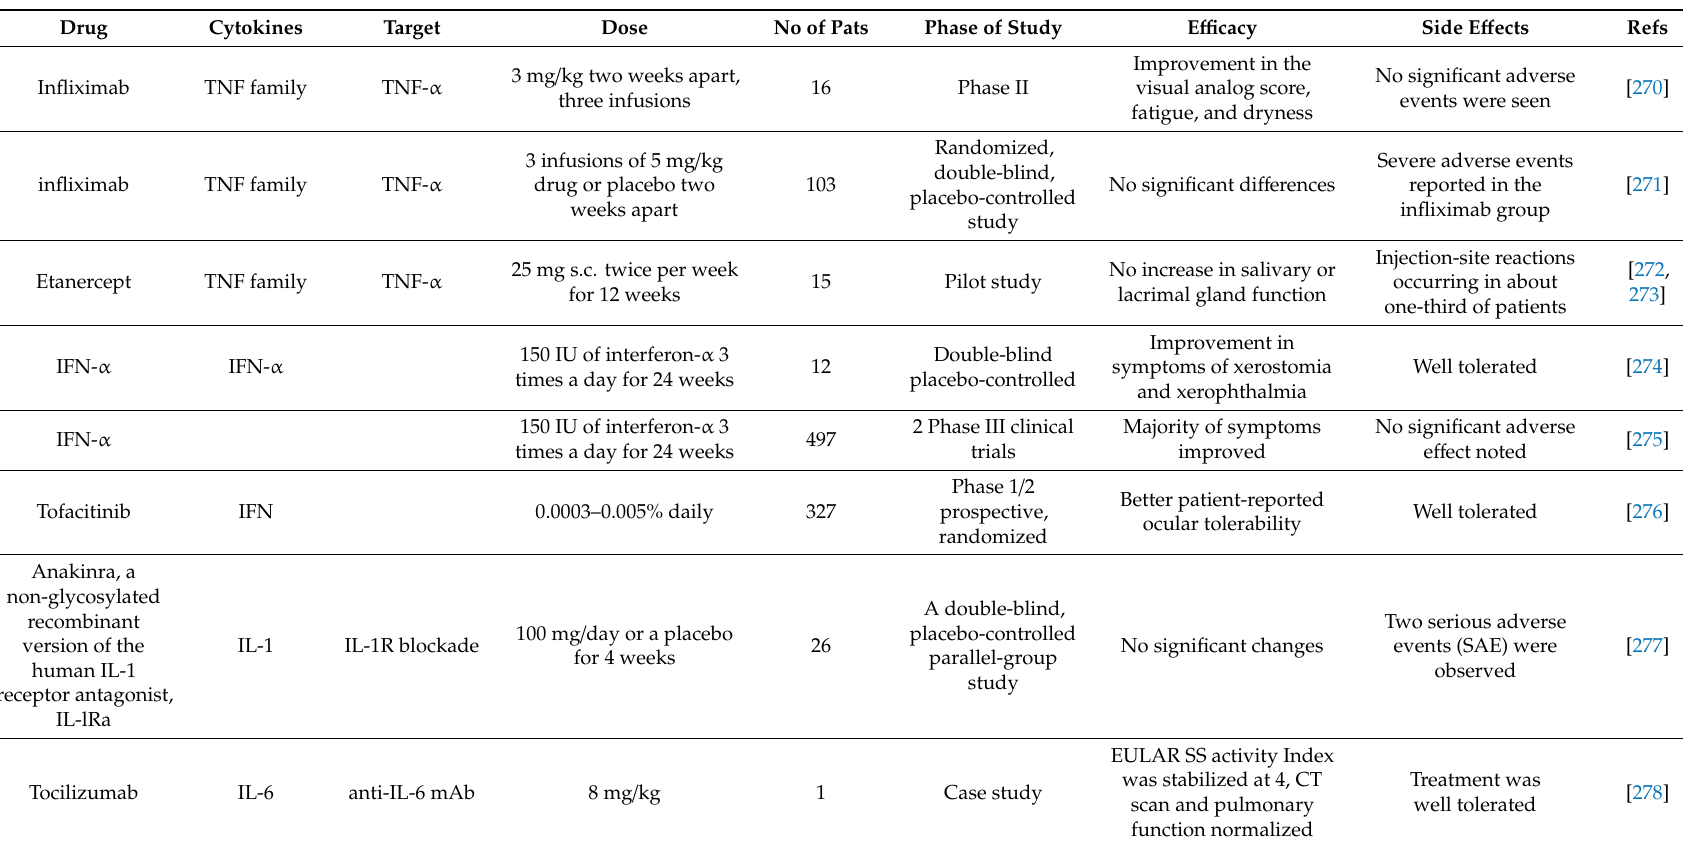
Table 4. Cytokine-targeted therapies in pSS